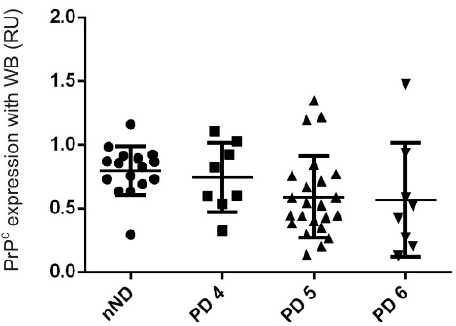
Figure 5. Graph representing densitometric study of PrP C immunoblot analysis in postmortem frontal cortex (Brodmann area 8) from PD patients at di ff erent stages compared to non-neurodegenerative cases (nND). Postmortem brain tissue was obtained from Hospital Clinic Brain Bank, following the Code of Ethics of the World Medical Association and the protocols of the local ethical committee. Each plot represents a quantitative level of PrP C standardized with actin level for each case.